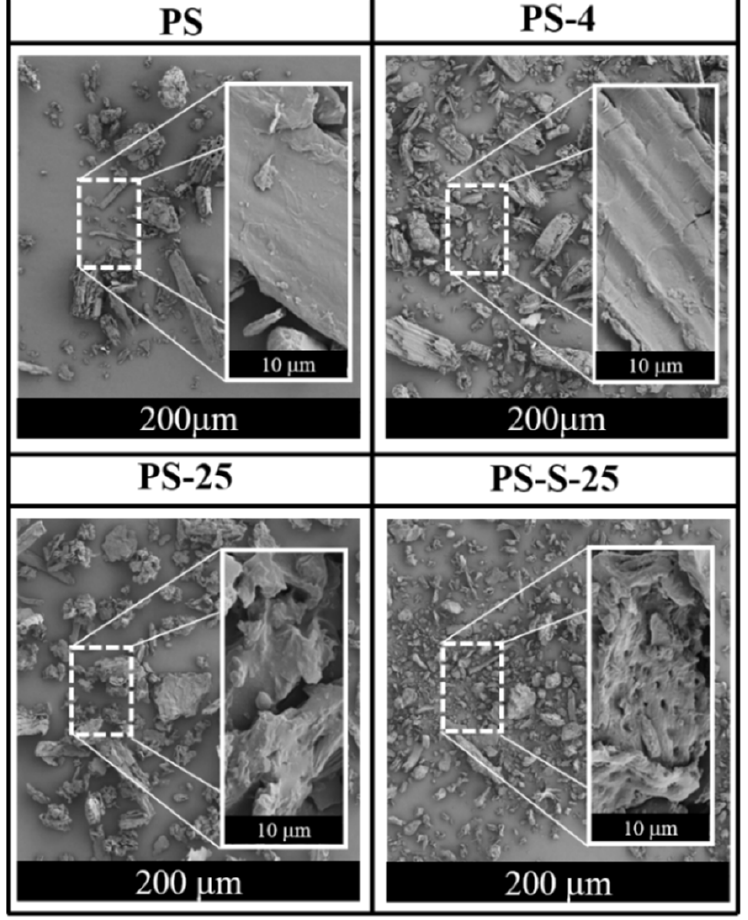
Figure 1. SEM images of PS, PS-4, PS-25, and PS-S-25.